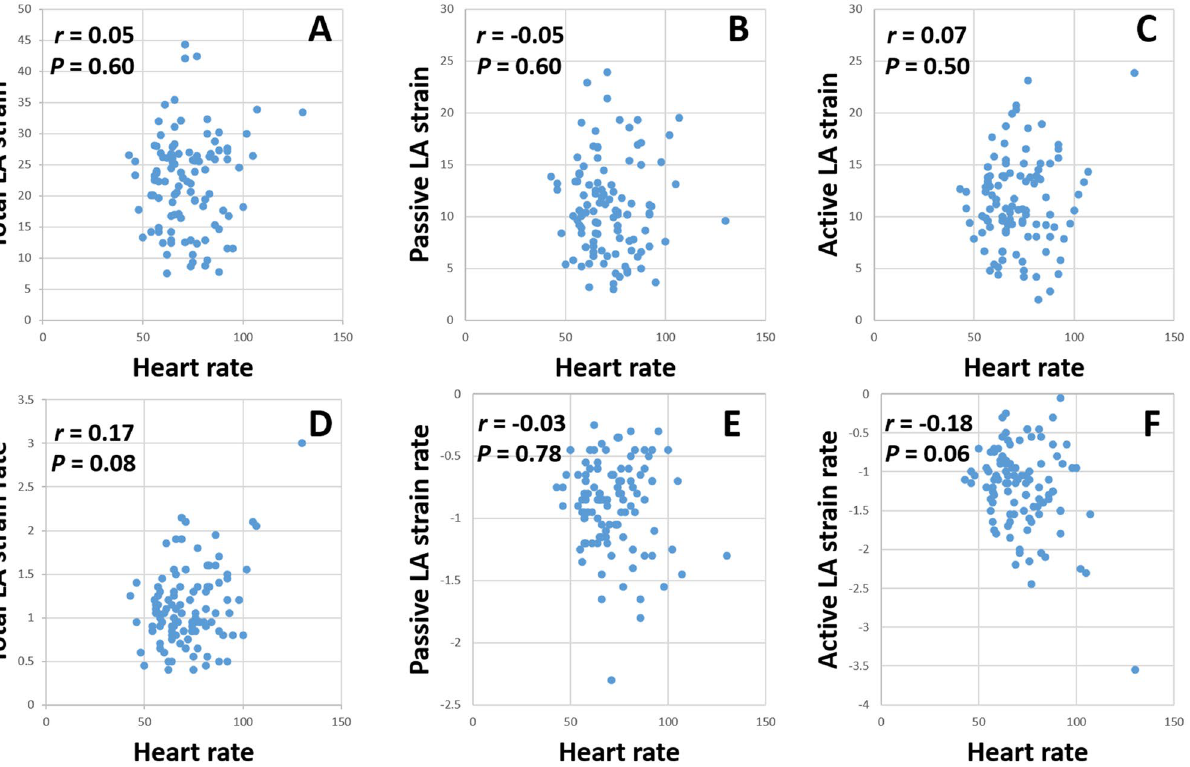
Figure 4. Correlation between the heart rate and ( A ) total LA strain, ( B ) passive LA strain, ( C ) active LA strain, ( D ) total LA strain rate, ( E ) passive LA strain rate, and ( F ) active LA strain rate.